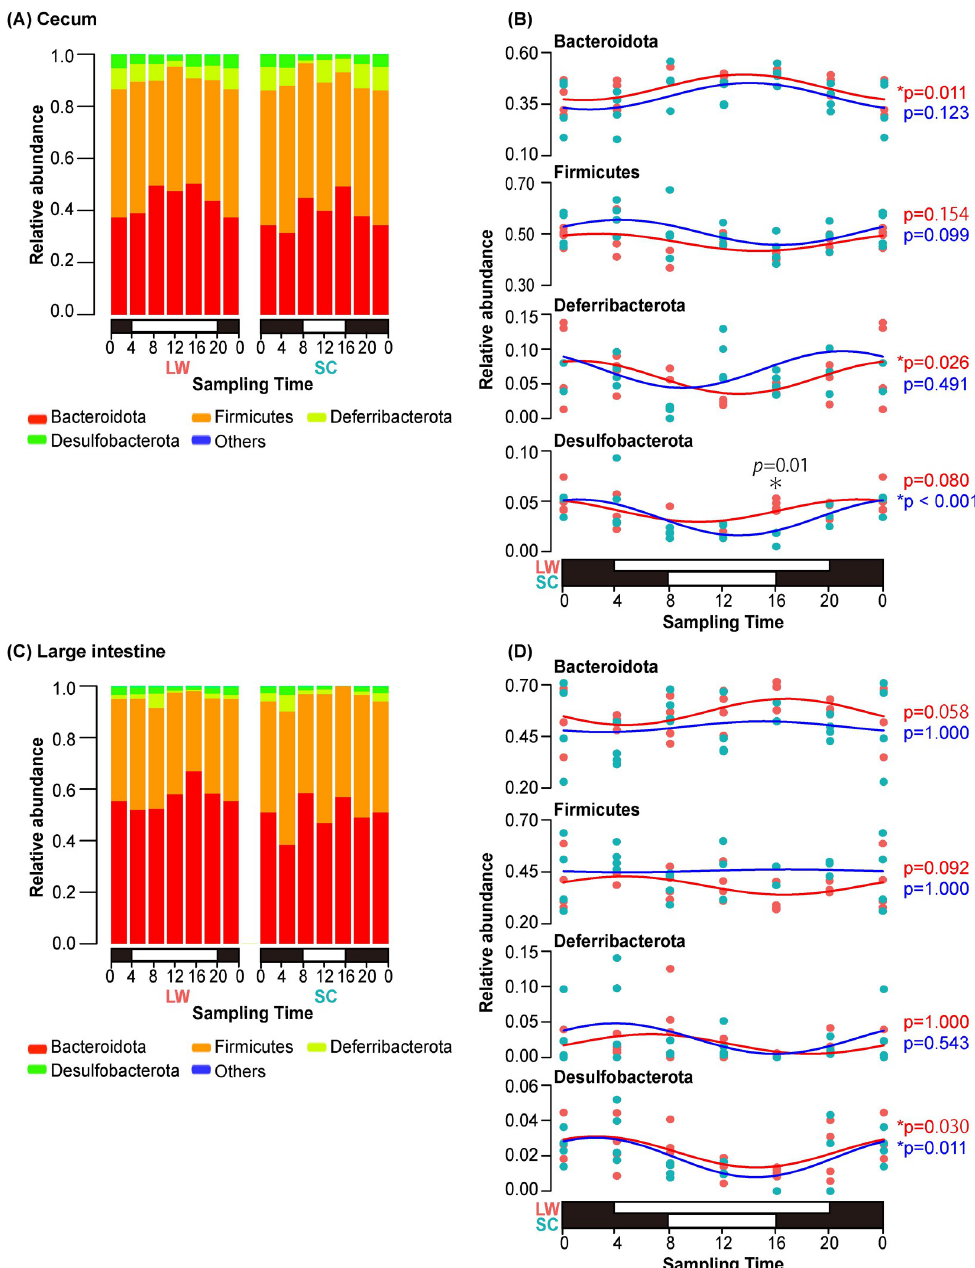
Fig 2. Daily variation in the composition of the microbiome under summer- and winter-mimicking conditions. Relative abundance of phylum level in (A) cecum and (C) large intestine of CBA/N mice. The horizontal axis indicates the sampling time, and the vertical axis indicates the average relative abundance of each bacterial phylum. The white and black bar with the horizontal axis indicates the light/dark cycle under LW/SC conditions. The number of individuals at each sampling time was 4. However, the number was 2 at two points (cecum LW 8:00 and large intestine SC 16:00) because some samples failed in the quality control process. The data of 0:00 were double-plotted for the same data. Curve fitting of the major bacterial phyla in (B) the cecum and (D) the large intestine and their relative abundance. Each dot represents one sample, and the color indicates the seasonal condition (red: LW; blue: SC). P -values are on the right side of the graph for those with significant rhythmicity using the JTK_Cycle ( p < 0.05). Asterisk indicates significant difference detected by t -test between LW and SC